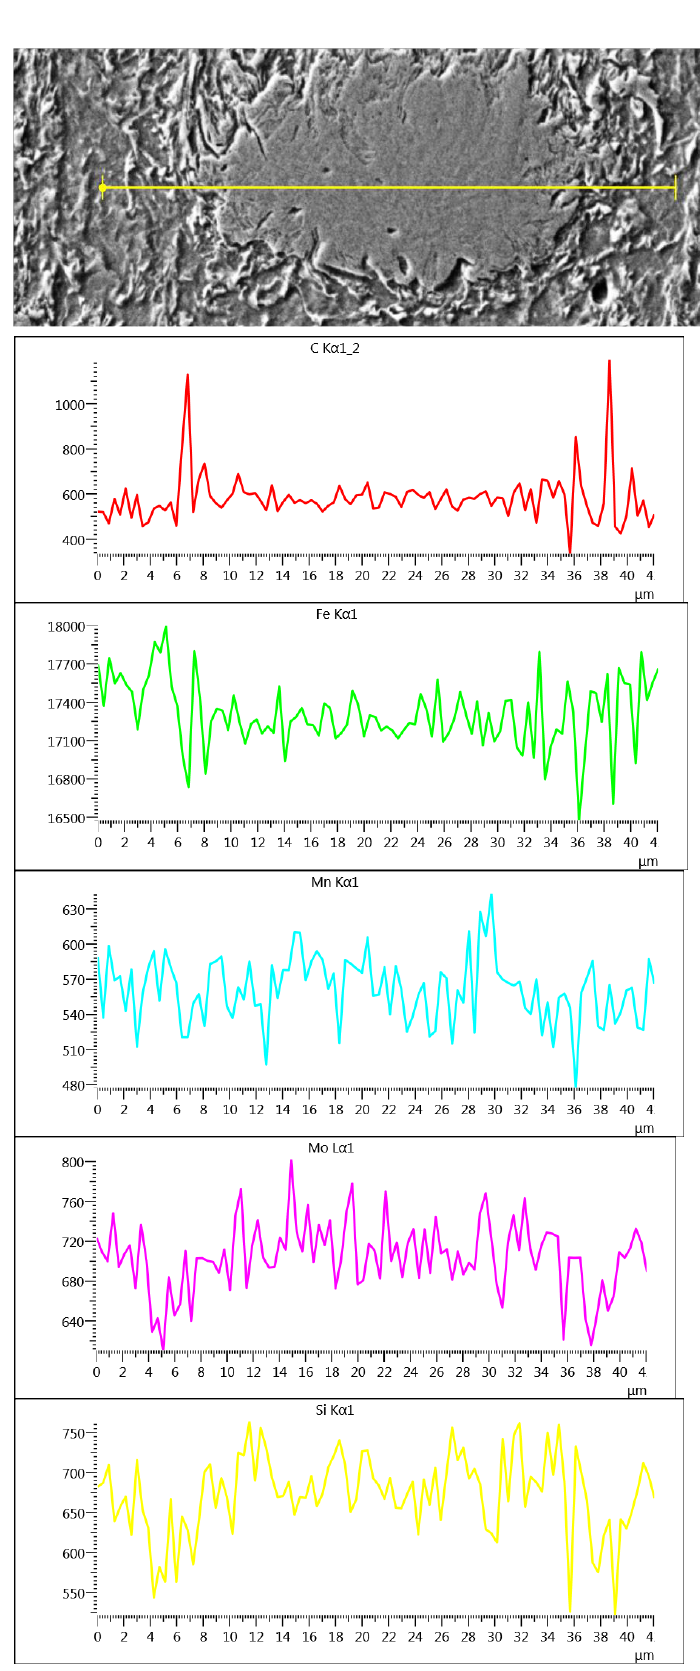
Figure 16. EDS analysis of dark fields from subarea IV.